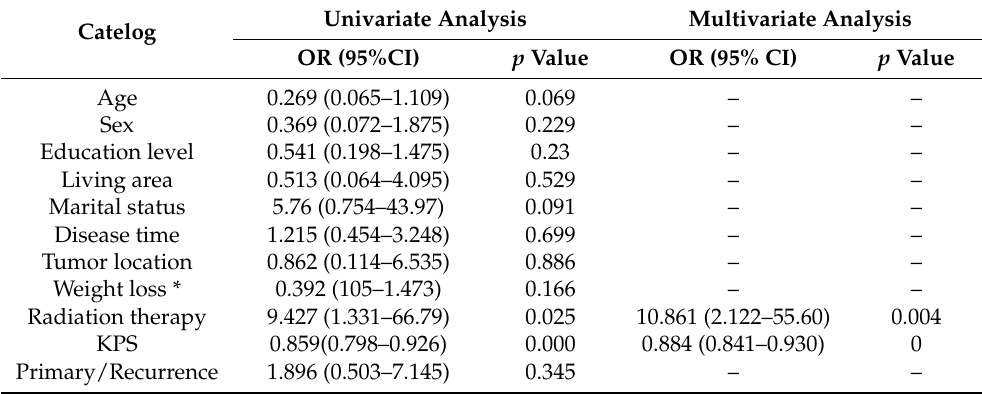
Table 3. Uni- and multivariate logistic analysis of factors associated with depression.